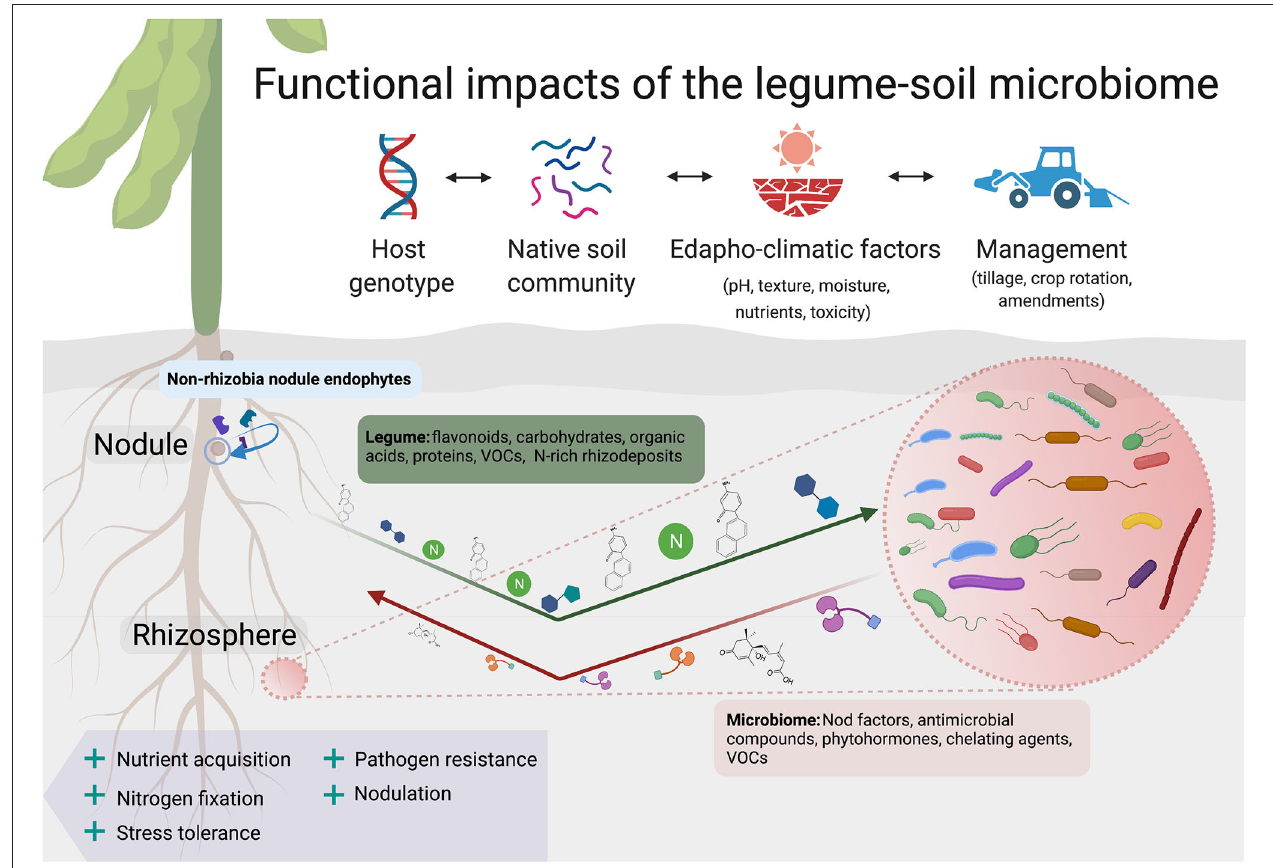
FIGURE 1 | Legumes form interspecific associations with endophytes and enrich the growth of other microbial communities within the rhizosphere. Plant-derived factors in the rhizosphere such as flavonoids, allelopathic phytochemicals, and nitrogenous compounds preferentially favor the growth of certain groups over others. This “filtering effect” (Xiao et al., 2017) ultimately leads to a decrease in diversity with increasing proximity to the legume root surface. The soil microbiome in turn influences legume performance through rhizospheric signaling that includes Nod factors, phytohormones, volatile organic compounds (VOCs), and antimicrobial compounds. Following legume root and nodule senescence, rhizobia, and other endophytes are released back into the rhizosphere. Multiple seasons of legume cropping may cause shifts in the abundance and activity of symbionts, PGPBs, and other rhizosphere-associated groups over time ( Thies et al., 1995; Ai et al., 2015). Legume impacts on the structure and function of the soil microbiome are mediated by numerous environmental factors and management practices, such as soil pH, tillage, and residue management. Created with